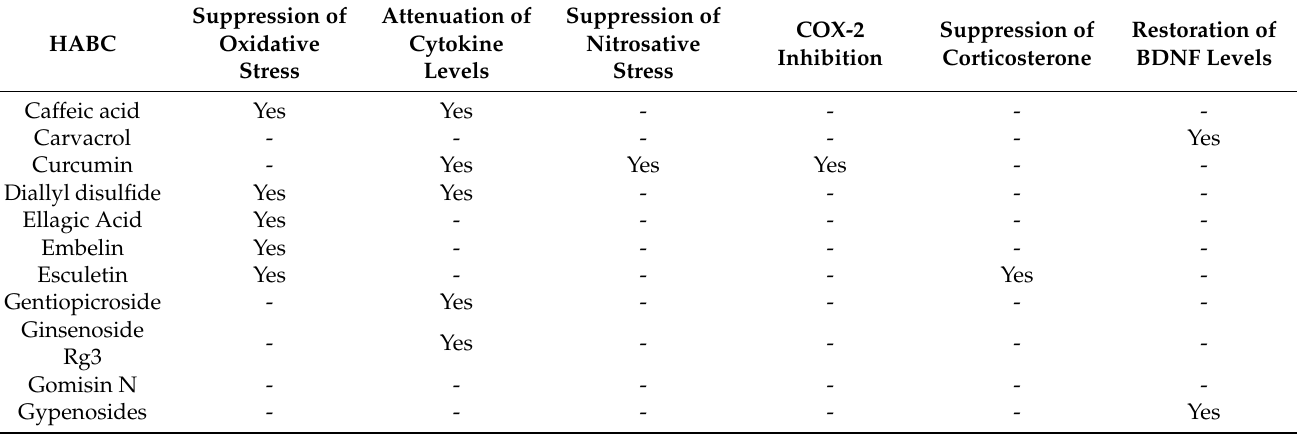
Table 2. Mechanism of action(s) of HBACs against LPS-induced sickness behaviour in